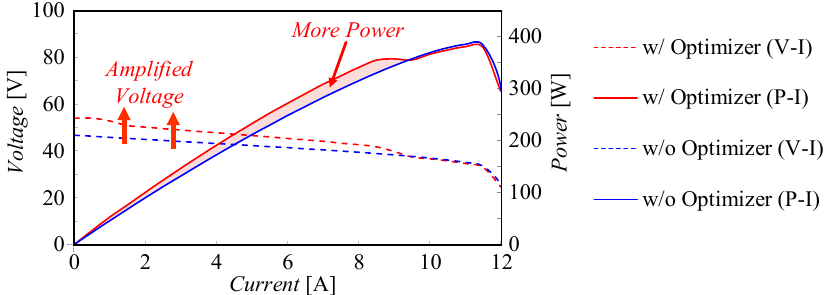
Figure 26. Performances comparison with and without the power optimizer using the designed PVE.